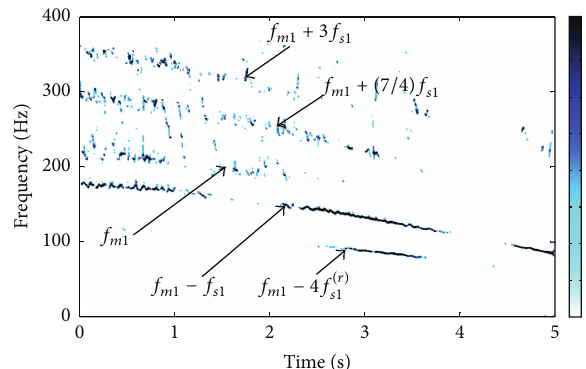
Figure 8: Reassigned scalogram of sun gear wear signal.